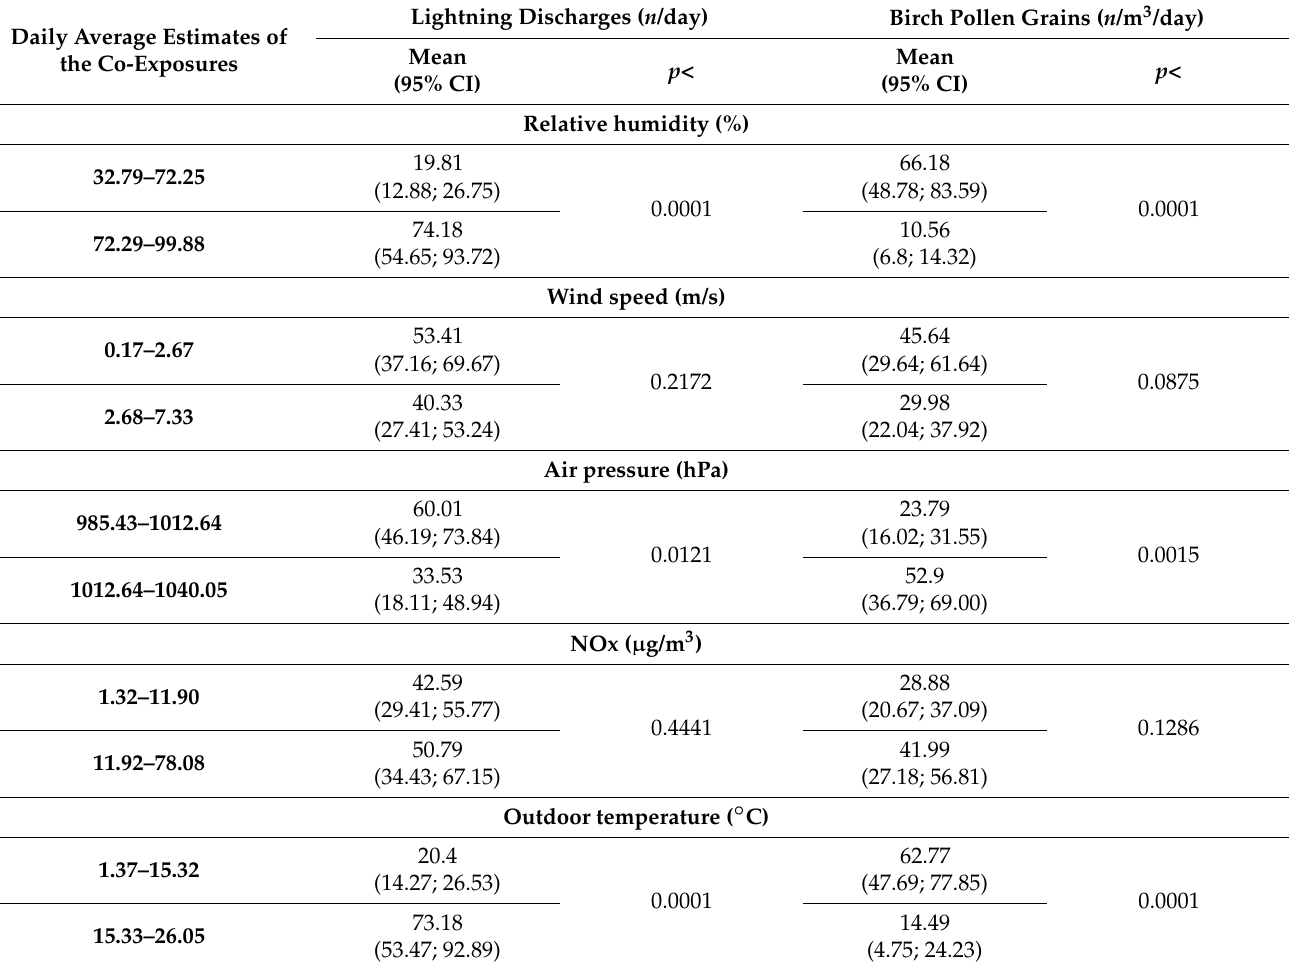
Table 1. Relationship between the main and co-exposures. The p values express statistical significance between sub-categories of each variable at the 95% CI